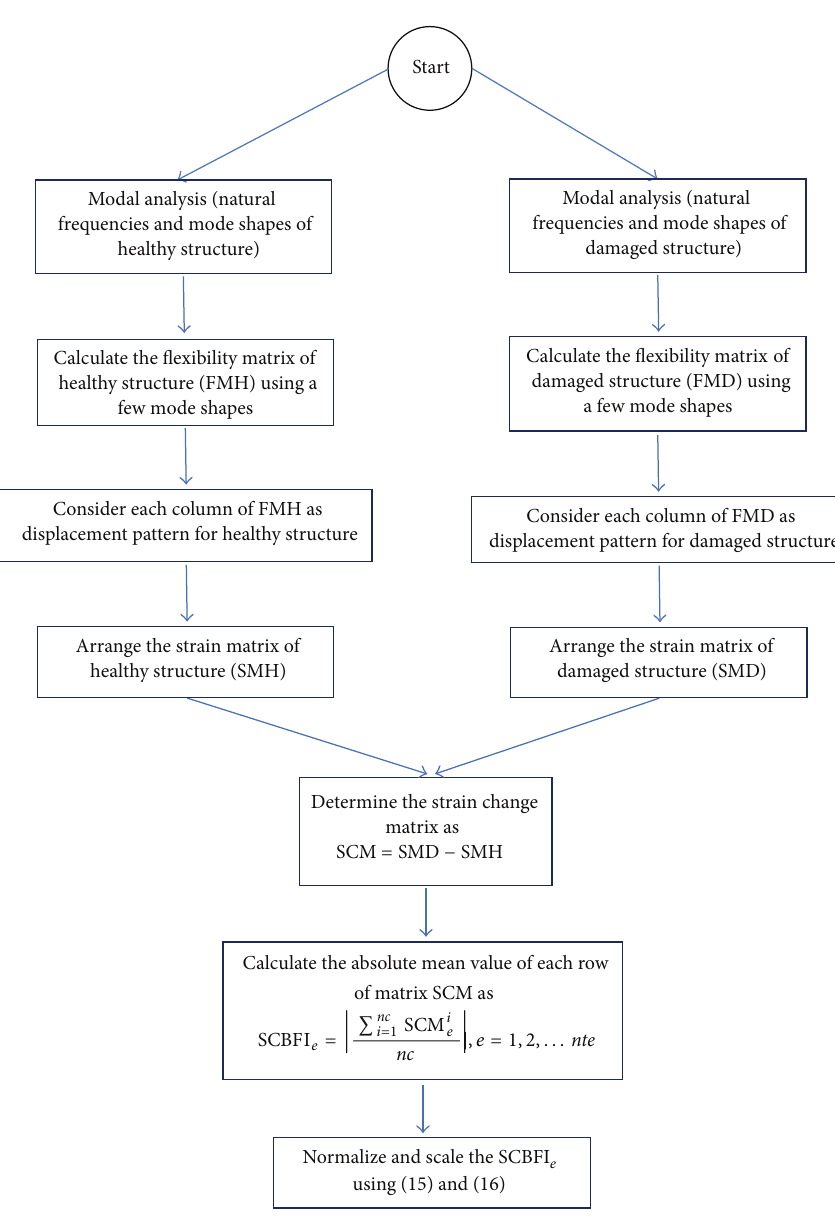
Figure 1: The process for constructing the SCBFI index.